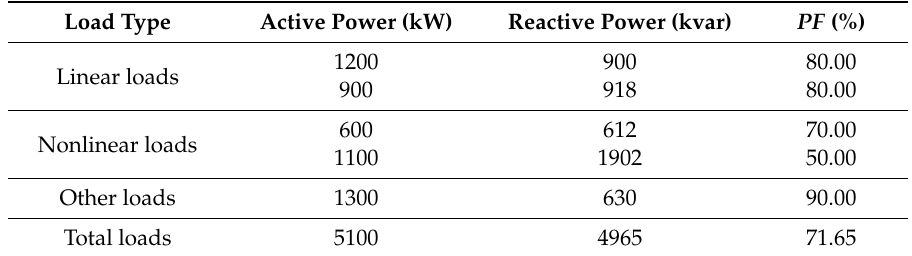
Table 2. Detailed industrial